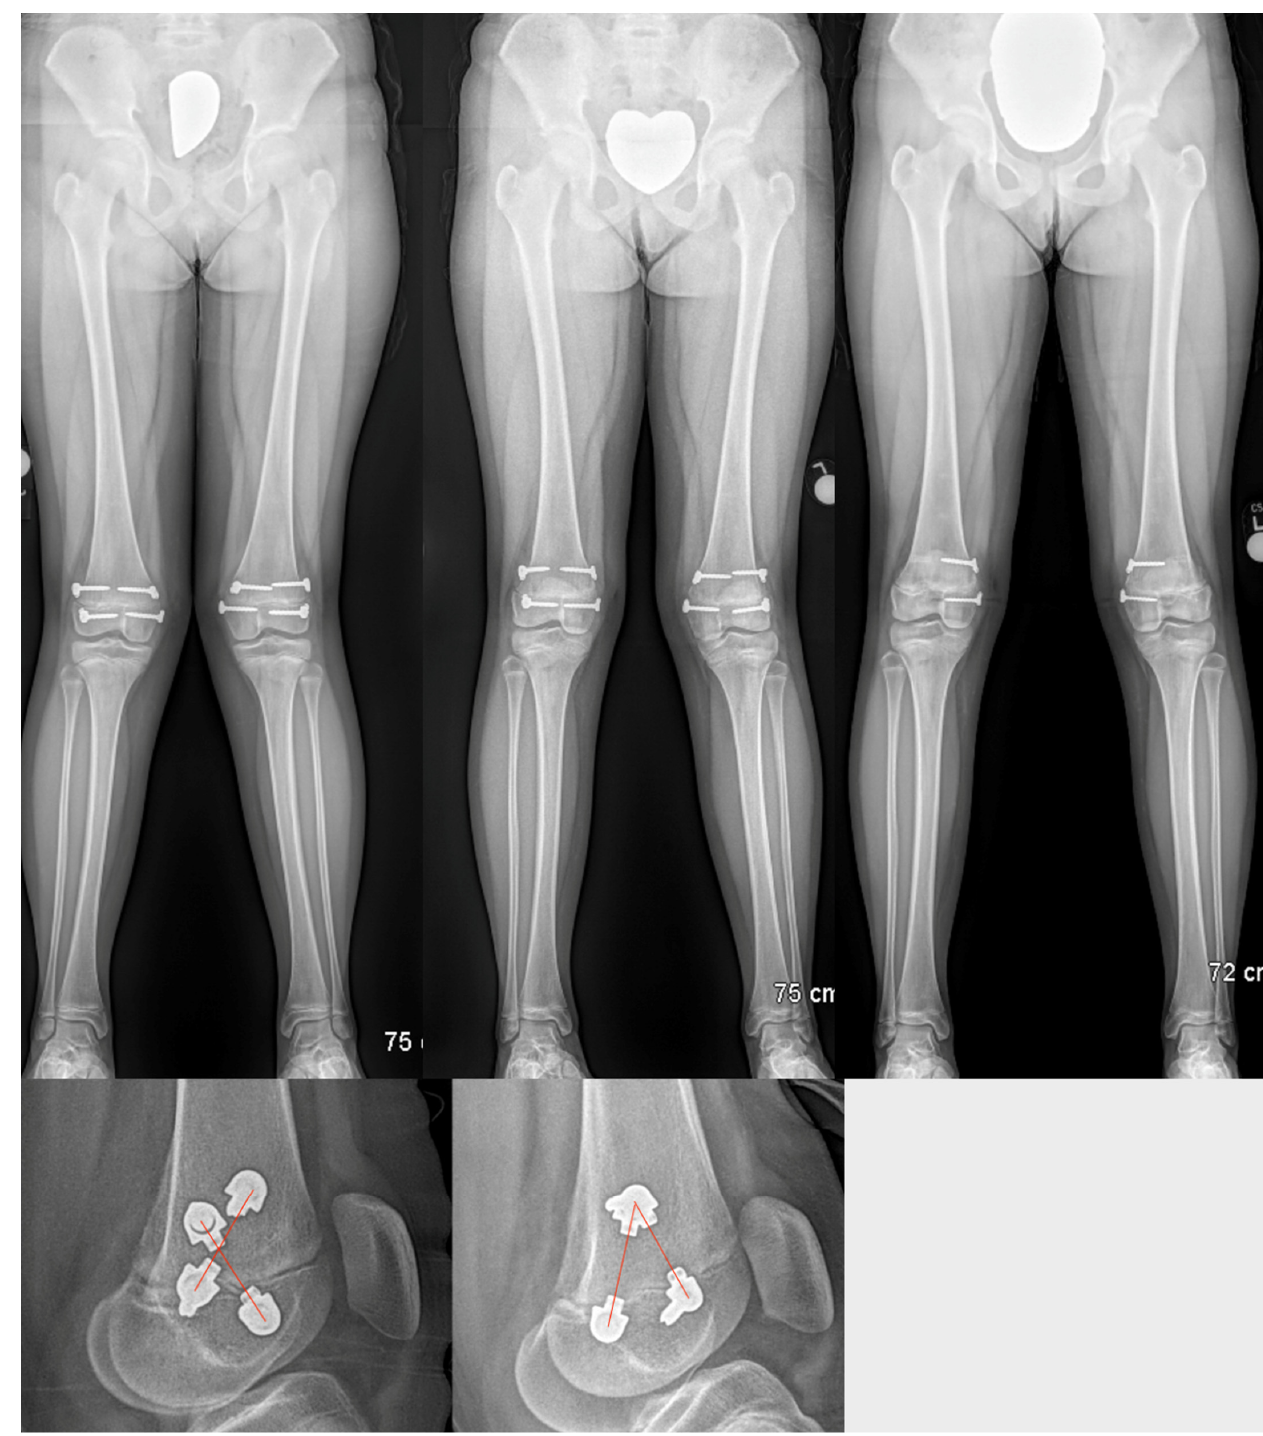
Figure 6. Standing radiographs of both lower limbs of the same patient as in Figures 1 and 5 (Patient #1) at the time of insertion of rotational guided growth implants ( top left ), end of rotational guided growth ( top middle ), and medial hemiepiphysiodesis with the medial implant to correct valgus ( top right ). The crossing angle of the plates is seen at the beginning ( lower left ) vs. at the end ( lower right ) of the correction. Note the change in crossing angle.